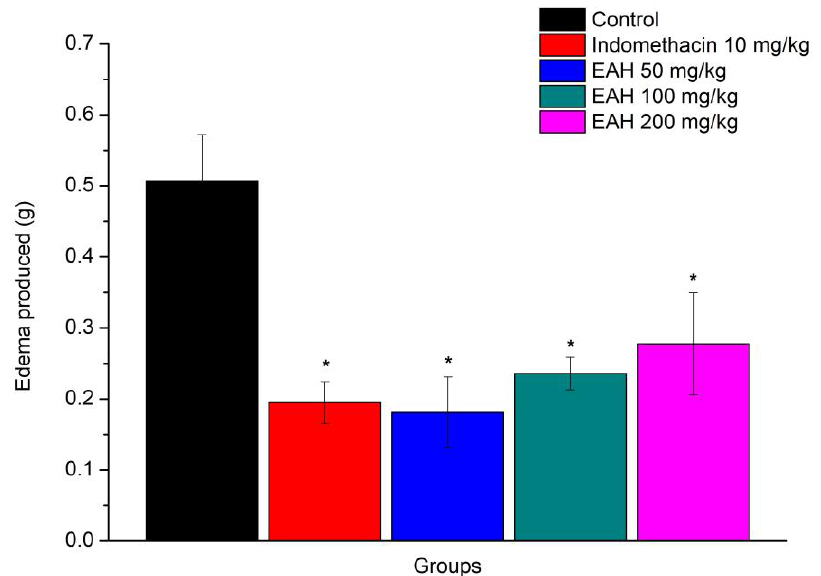
Figure 1. Average ( ± EPM) of the anti-edematogenic activity of EAH at doses of 50, 100, and 200 mg/kg. The values presented in the graph represent the difference in the volume of water displaced in mL of the right hind paw, * p < 0.05 when compared to the control group ( n = 5 for all groups). ANOVA followed by Duncan's test.